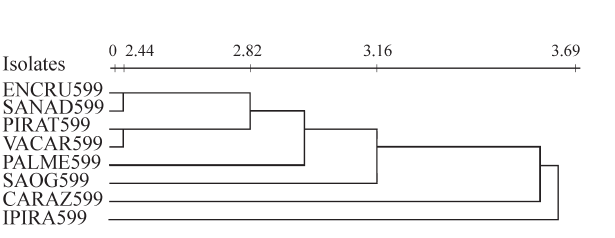
Figure 5 - Dendrogram of the relationships between Drechslera teres iso- lates based on random amplified polymorphic DNA (RAPD) analysis.